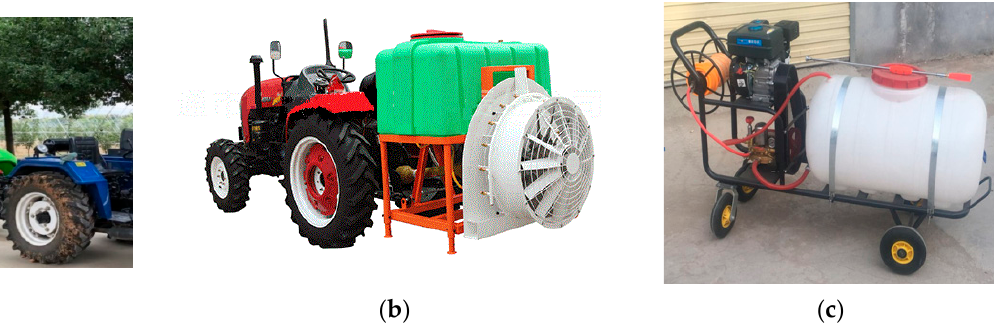
Figure 1. Orchard sprayers used for pesticide application. ( a ) 3WQF-1000 trailer air-assisted sprayer, ( b ) 3WG-500 mounted air-assisted sprayer, ( c ) handheld spray gun. ( b ) 3WG-500 mounted air-assisted sprayer, ( c ) handheld spray